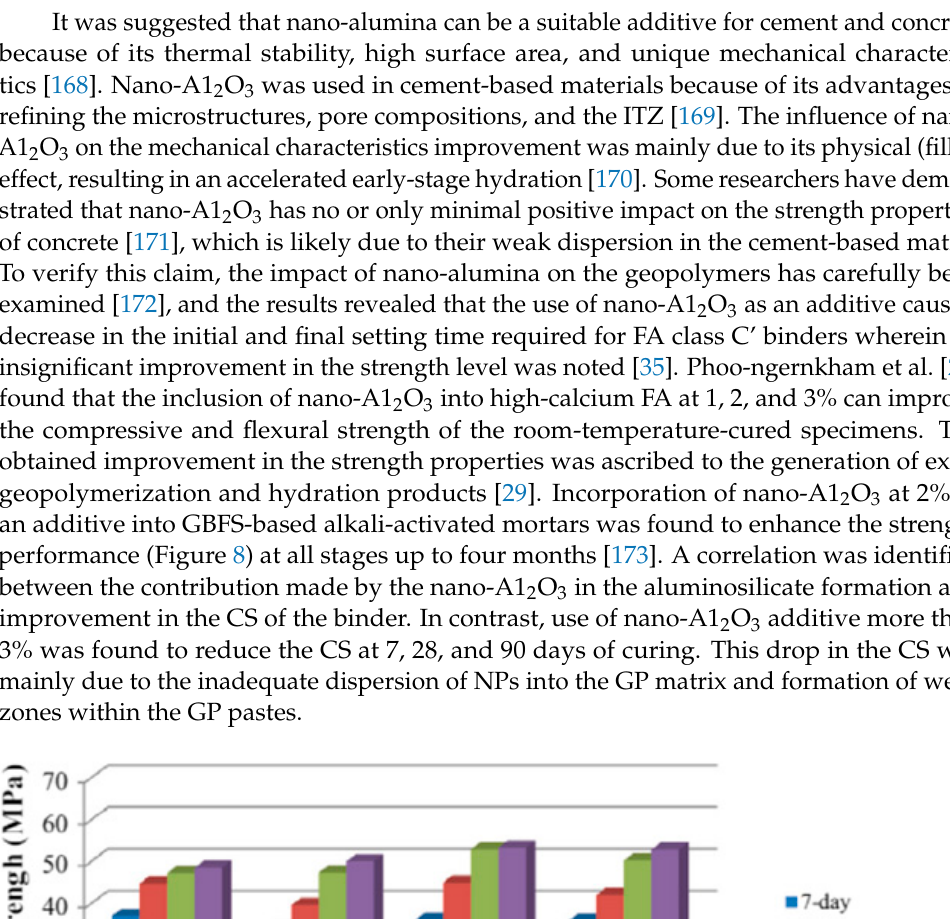
Figure 7. Influence nanosilica content on CS of ( a ) GBFS-FA [167] and ( b ) GBFS specimen [148].